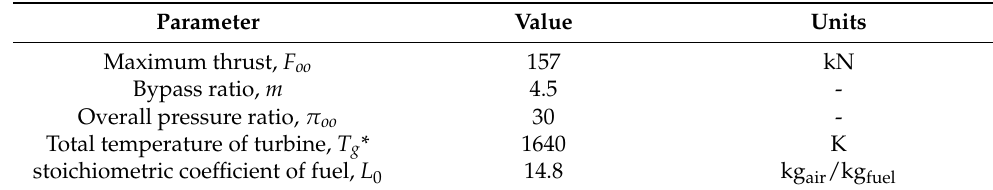
Table 1. Initial value for thermodynamic engine model.